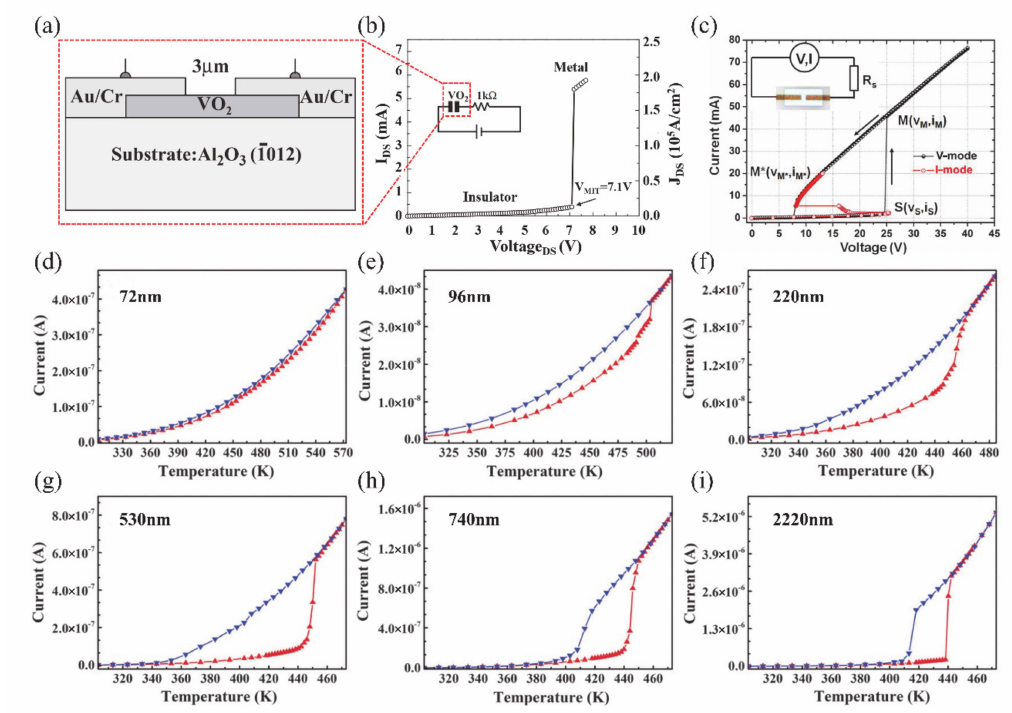
Figure 18. ( a ) Test circuit diagram of VO 2 thin film MIT monitored by switching voltage pulse. ( b ) MIT driven by a DC voltage in VO 2 thin film. Reproduced from [7], with permission from Elsevier, 2005. ( c ) I–V curve of a two-terminal VO 2 switch, M* means that when the voltage is reduced, VO 2 reaches point M* where VO 2 transforms back to an insulator. Reproduced from [125], with permission from IOP Publishing, 2010. ( d – i ) Temperature-current hysteresis loops with different widths of VO 2 (A) NW, ( d ) 72 nm, ( e ) 96 nm, ( f ) 220 nm, ( g ) 530 nm, ( h ) 740 nm and ( i ) 2220 nm. Reproduced from [20], with permission from Royal Society of Chemistry,